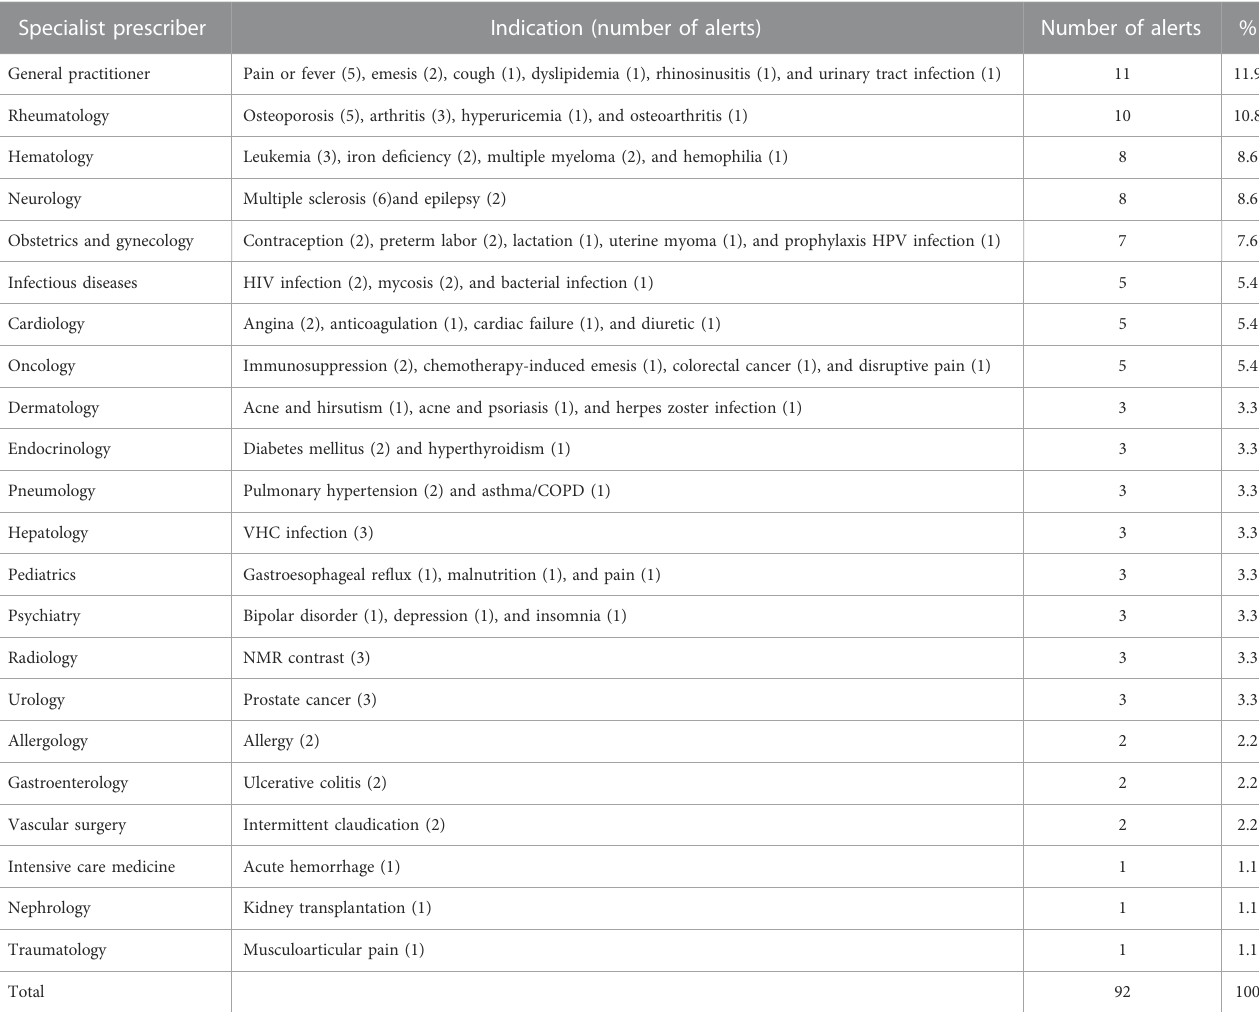
TABLE 8 Indication of drugs involved in alerts and potential specialist